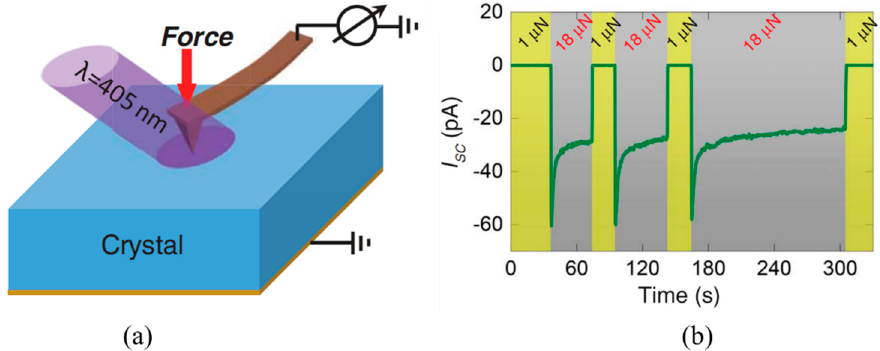
Figure 23. ( a ) Schematic of the AFM tip applying a load to generate a strain gradient in an illuminating area of dielectrics. ( b ) Evolution of the photocurrent from the flexoelectric response with forces for SrTiO 3 single crystals. Reprinted with permission from [104]. Copyright 2018 American Association for the Advancement of Science.